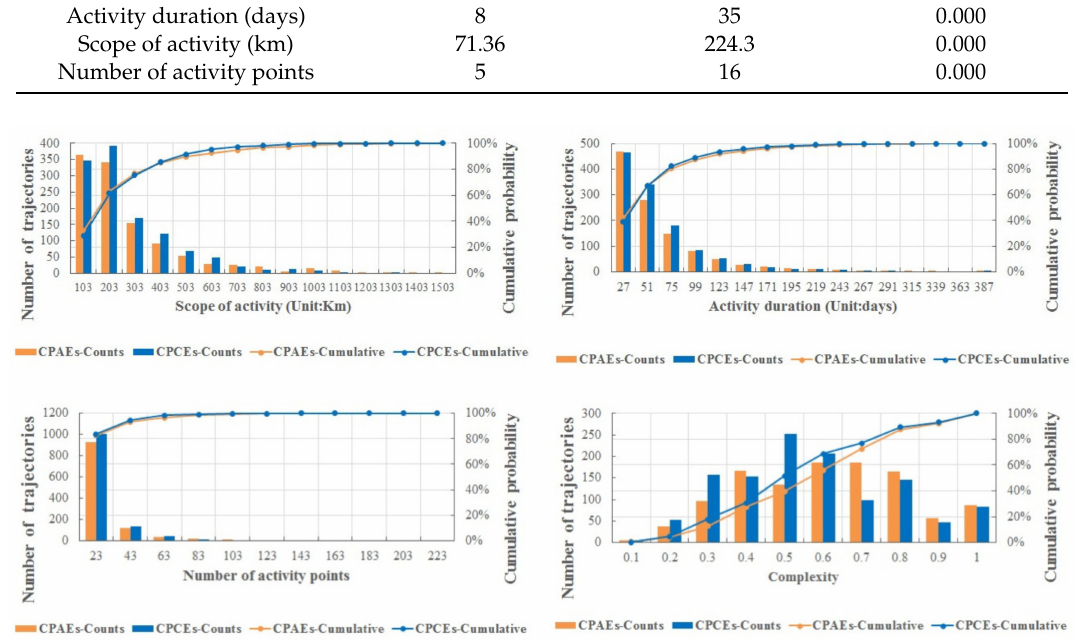
Figure 9. Statistics of the mobility indexes of CPAEs and